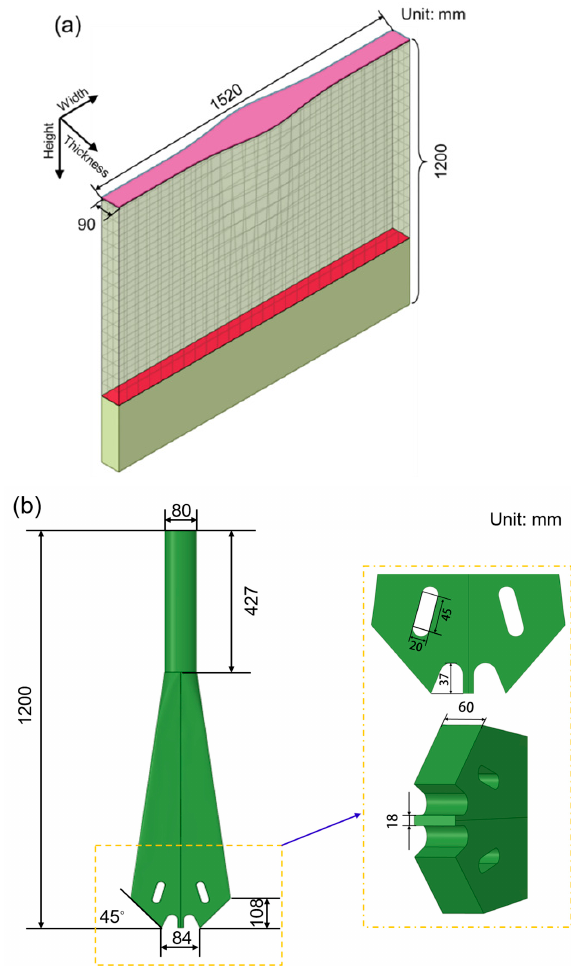
Figure 3. Three-dimensional geometric model and dimensional description. ( a ) Funnel mold and ( b ) submerged entry nozzle.